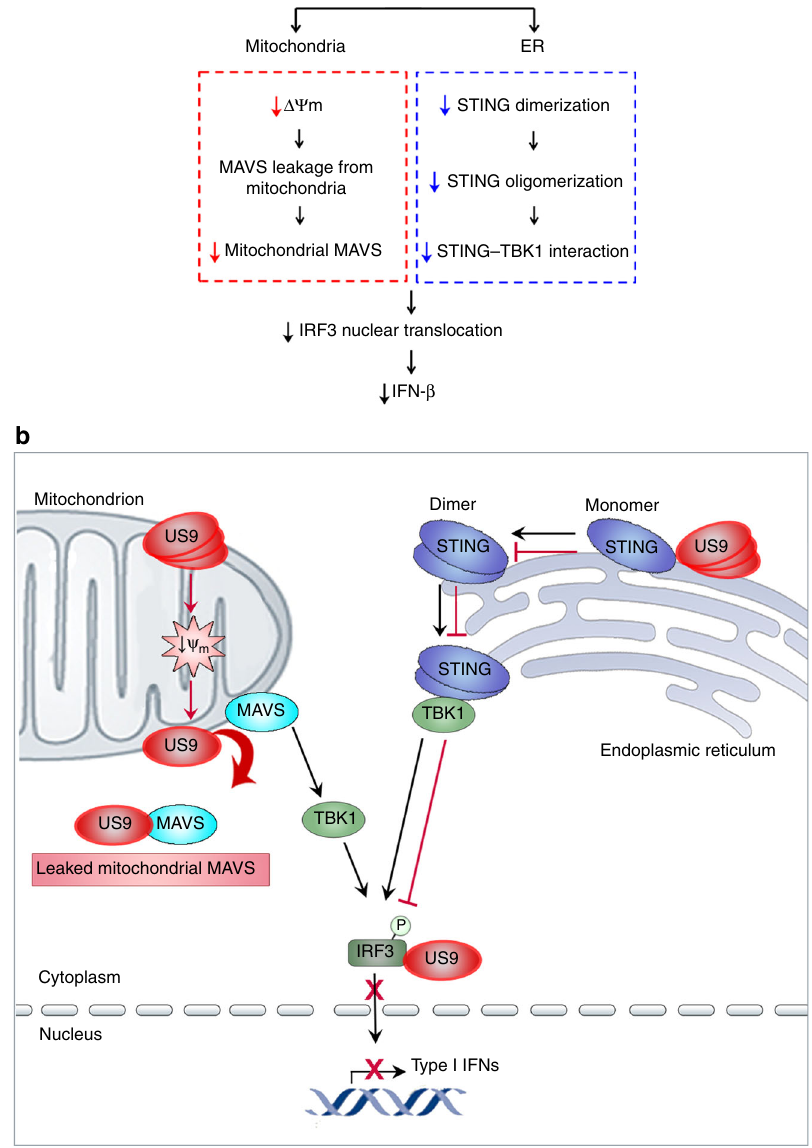
Fig. 7 Proposed model of HCMV US9-mediated inhibition of IFN- β signaling. a Flowchart of US9-mediated negative regulation of IFN- β by targeting MAVS axis at the mitochondria and STING axis in the ER. b Schematic model of US9-mediated negative regulation of IFN- β by targeting MAVS and STING signaling pathways